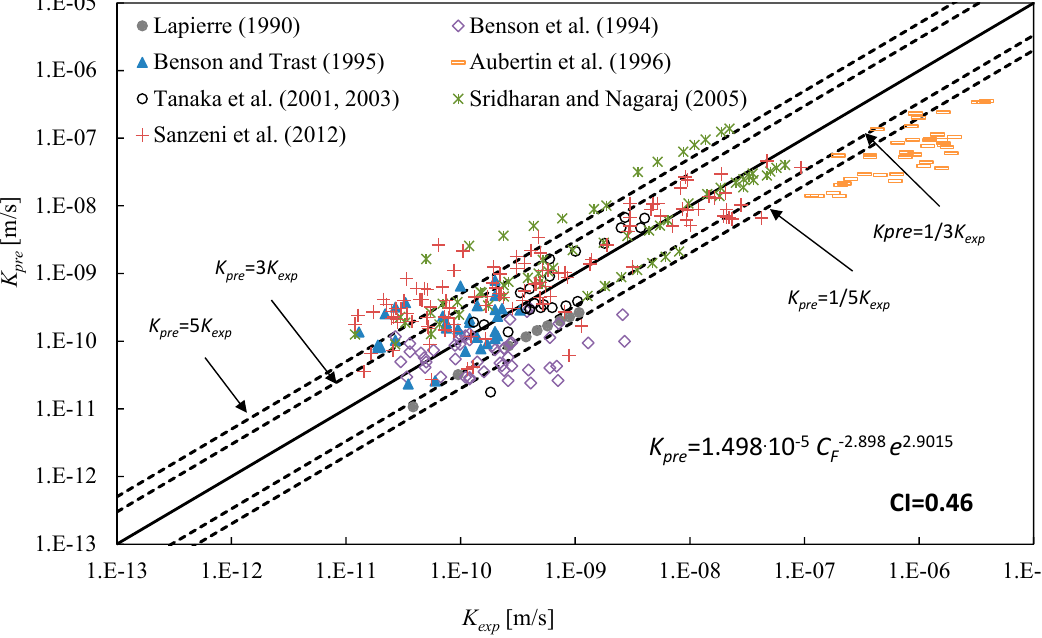
Figure 3. Experimental ( K exp ) and predicted value ( K pre ) of the saturated hydraulic conductivity as determined by Equation (20).